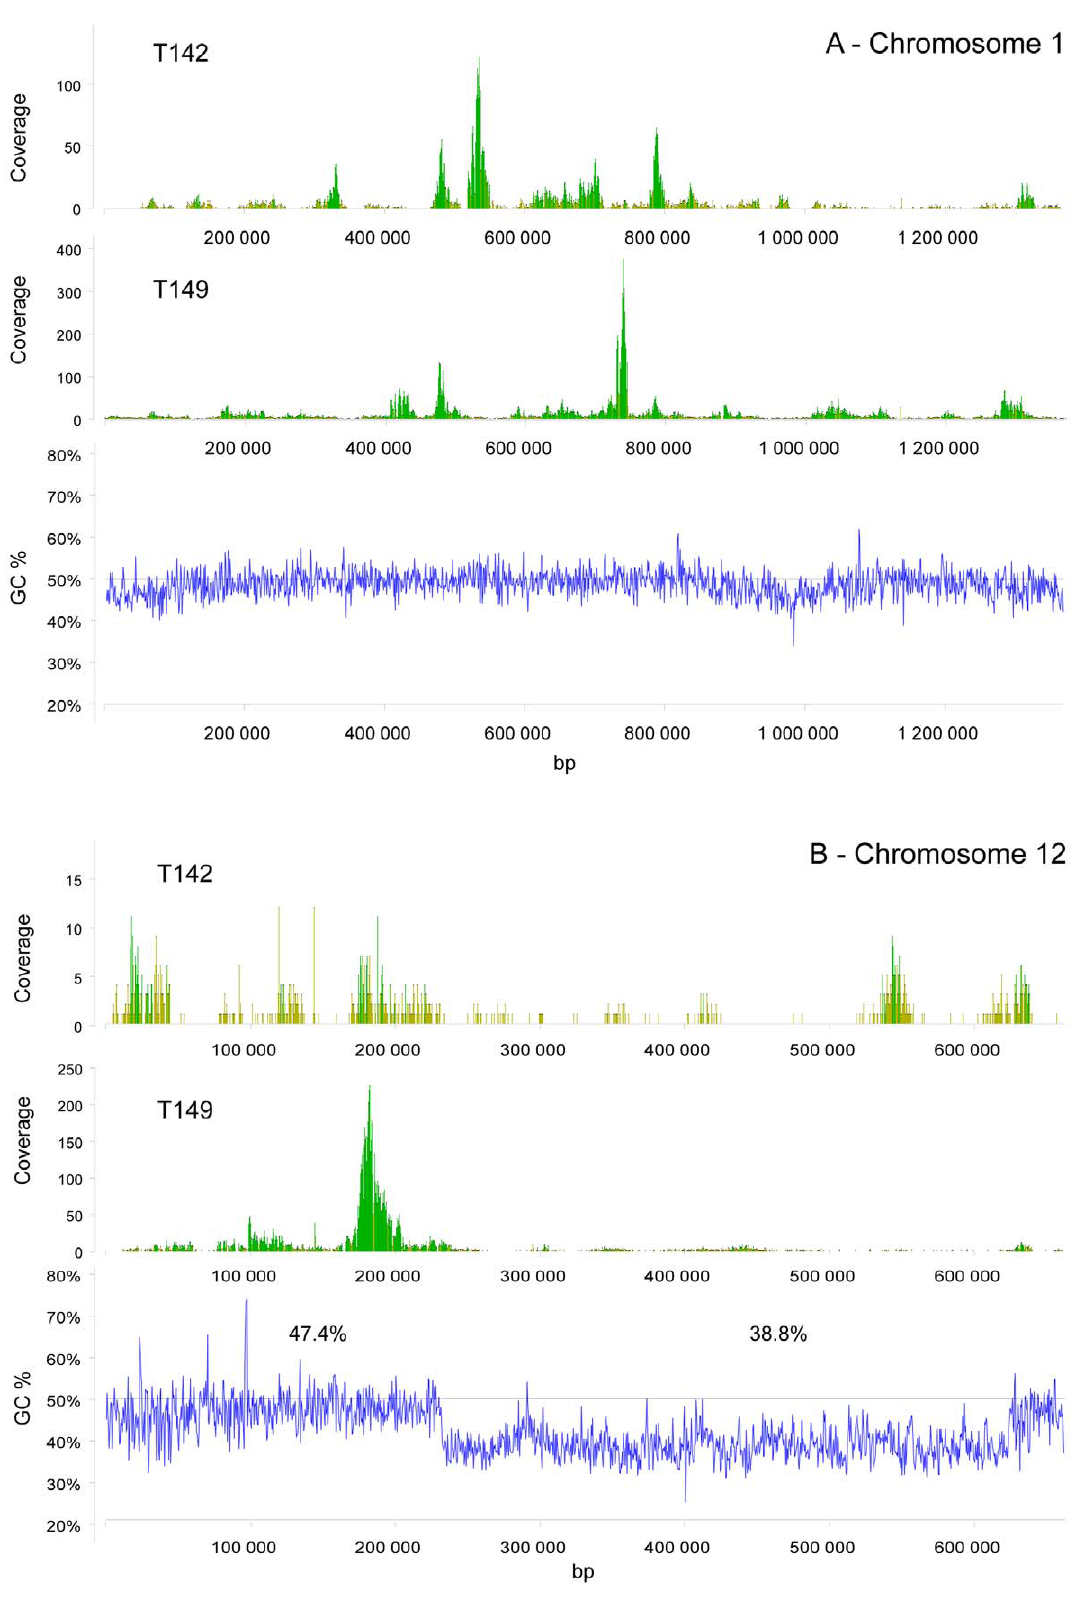
Figure 2. GC content and coverage depth by reads from the eastern South Pacific picoeukaryote samples T142 and T149 of individual chromosomes of B.prasinos RCC1105. (A) Chromosome 1. (B) Chromosome 14.